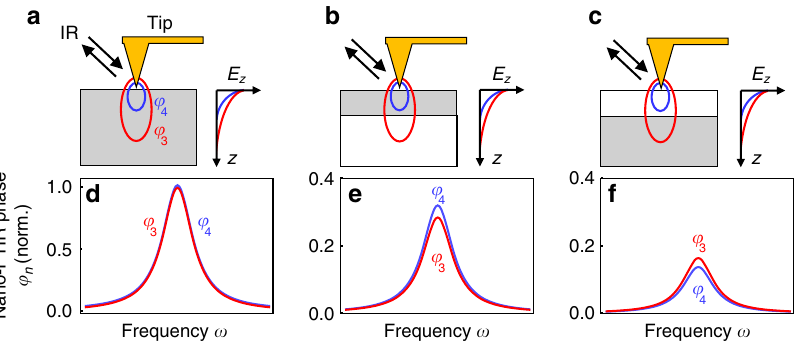
Fig. 7 Illustration of the peak height ratio criterium. a – c Schematic of the nano-FTIR experiment employing different higher harmonic demodulation orders n = 3 (red) and n = 4 (blue) for three samples with different geometries: a bulk material, b thin surface layers, and c subsurface layers. Gray areas mark the absorbing material. Ellipses below the tip illustrate the probing volumes. Graphs illustrate the exponential decay of near fi elds E z for different demodulation orders. d – f Sketch of qualitative nano-FTIR phase spectra, corresponding to panels a – c . For a given n , all φ n spectra are normalized to φ max n of